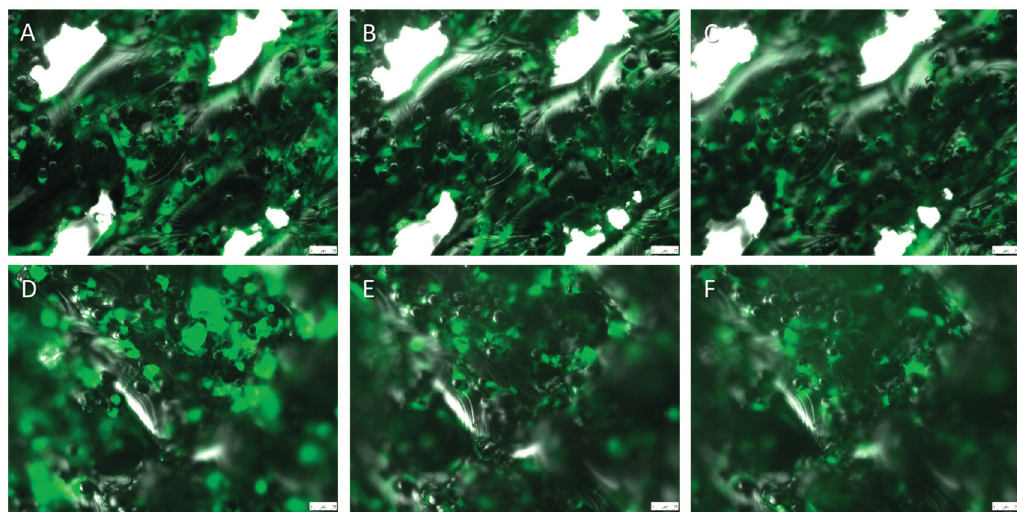
Figure 4. Comparison of chemotactic behavior of the endothelial cell line (GM7373) using vascular endothelial growth factor (VEGF), high mobility group box 1 (HMGB1), chemokine (C-X-C motif) ligand 12 (CXCL12) and combinations of HMGB1/CXCL12 and HMGB1/VEGF. For migration assays the negative control was set one and the other factors are its multiple. HMGB1 was more chemotactic than VEGF. CXCL12 induced lower migration of endothelial cells. Both factor combinations showed similar chemotaxis. Statistical test is two sample t –test with n = 6 (* p < 0.05).